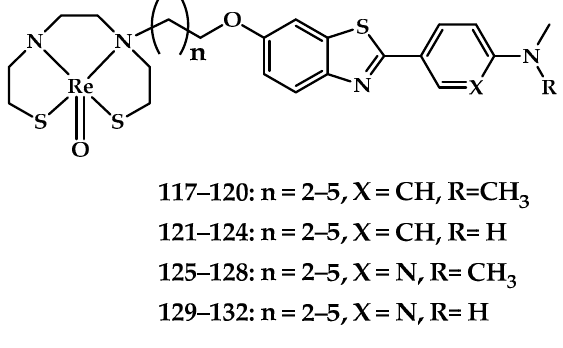
Figure 28. Re(III) coordination compounds 117 – 132 based on 2-arylbenzothiazoles conjugated with a BAT chelating moiety.